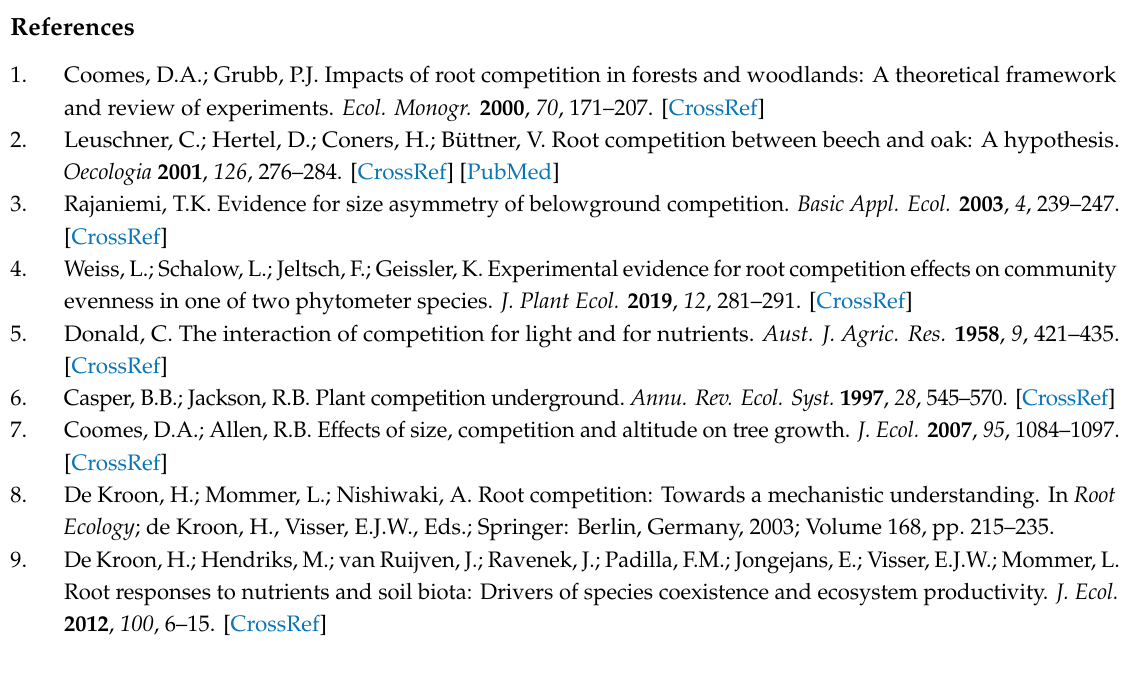
Table S1: Soil properties in the microcosms and competition chamber. Tables S2–S11: Statistical output of GLMs. Figure S1: Coarse root biomass of Acer and Fagus . Figure S2: Fine root carbon-to-nitrogen ratio of Acer and Fagus . Supplementary Material S1: Detailed description of the experimental set-up, irrigation and fertilization, Supplementary Material S2: Methods used to determine soil chemical properties. Supplementary Material S3: Fine root carbon concentration and C:N ratio. Supplementary Material S4: